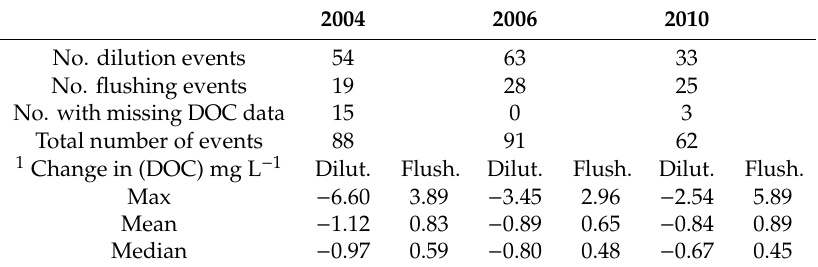
Table 2. Summary data for dilution and flushing events for the three selected study.